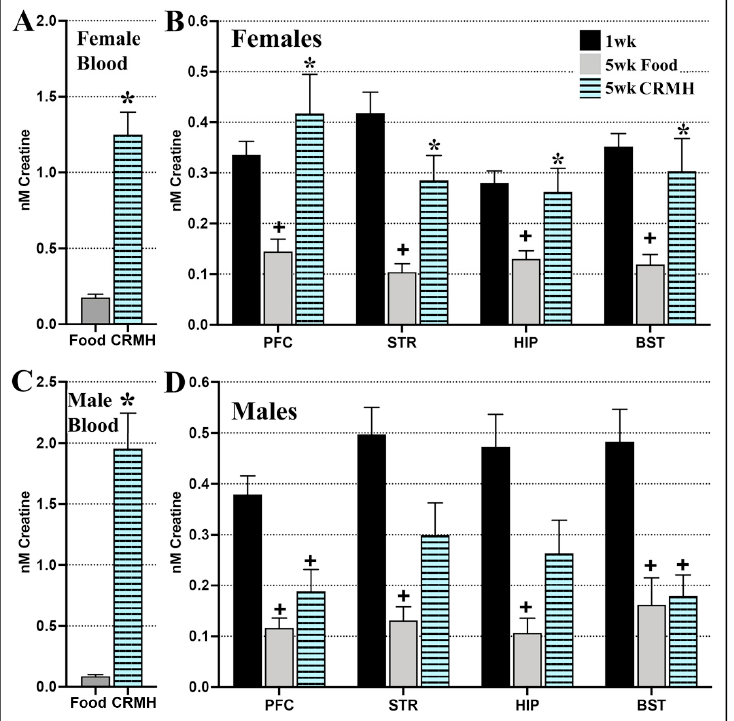
Figure 4. Dietary CRMH significantly increases creatine levels in the blood and brain of both sexes at altitude. ( A ). In females at altitude, dietary CRMH significantly increased blood creatine levels vs. food alone. ( B ). In females, CRMH augmentation significantly increased creatine in the PFC, STR, HIP and BST vs. food controls. Dietary CRMH was effective at resolving the drop in